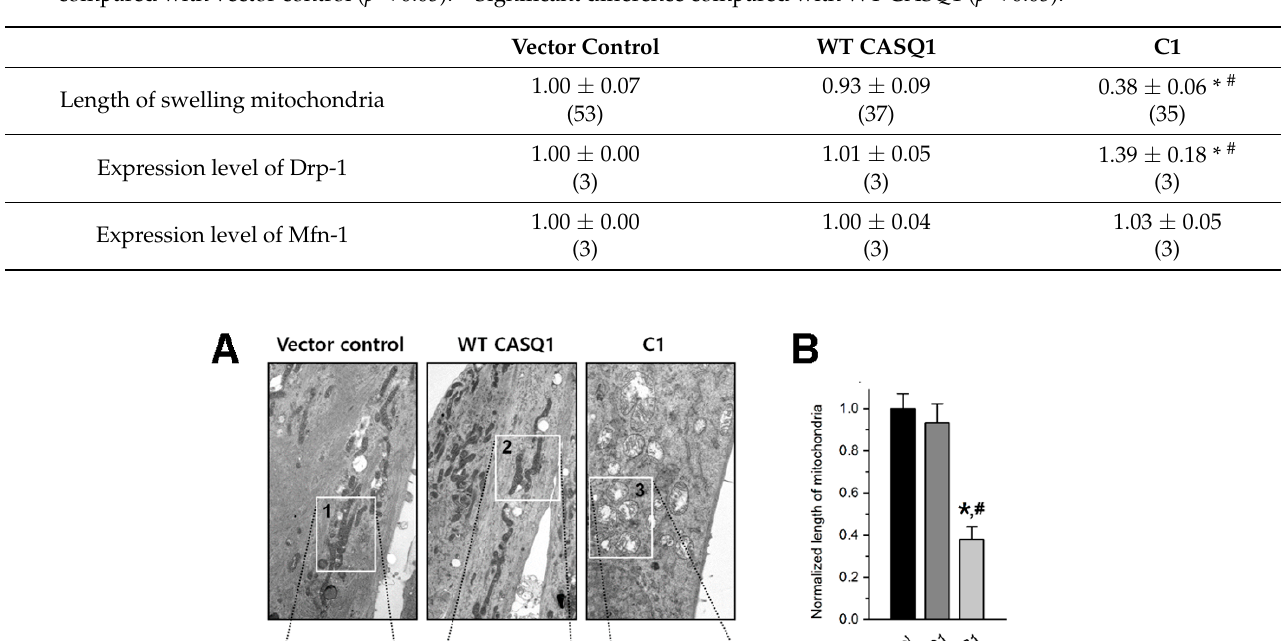
Table 2. Length of mitochondria and expression level of Drp-1 or Mfn-1 in mouse primary skeletal myotubes that expressed the WT CASQ1 or C1 region. The values are presented as the mean ± SEM for the number of mitochondria or experiments shown in parentheses. The values were normalized to the mean values of the vector control. * Significant difference compared with vector control ( p < 0.05). # Significant difference compared with WT CASQ1 ( p < 0.05).